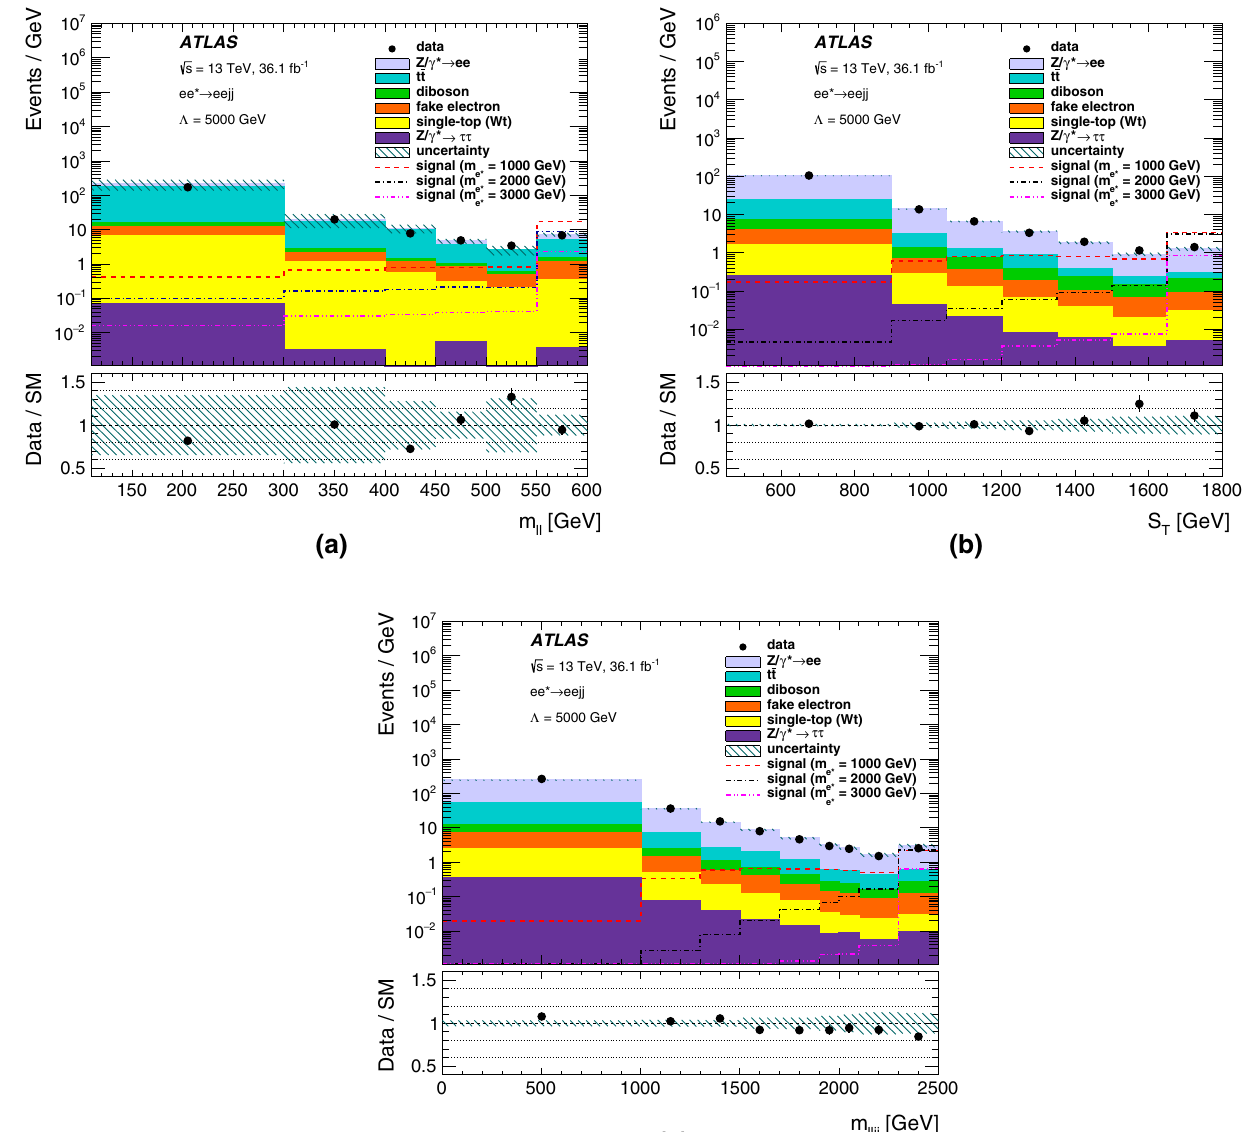
Fig. 3 The distributions of a m (cid:10)(cid:10) , b S T , and c m (cid:10)(cid:10) jj used to discrim- inate the signal from background processes in the eejj channel. The distributions are shown after applying the preselection criteria. The background contributions are constrained using the CRs. The